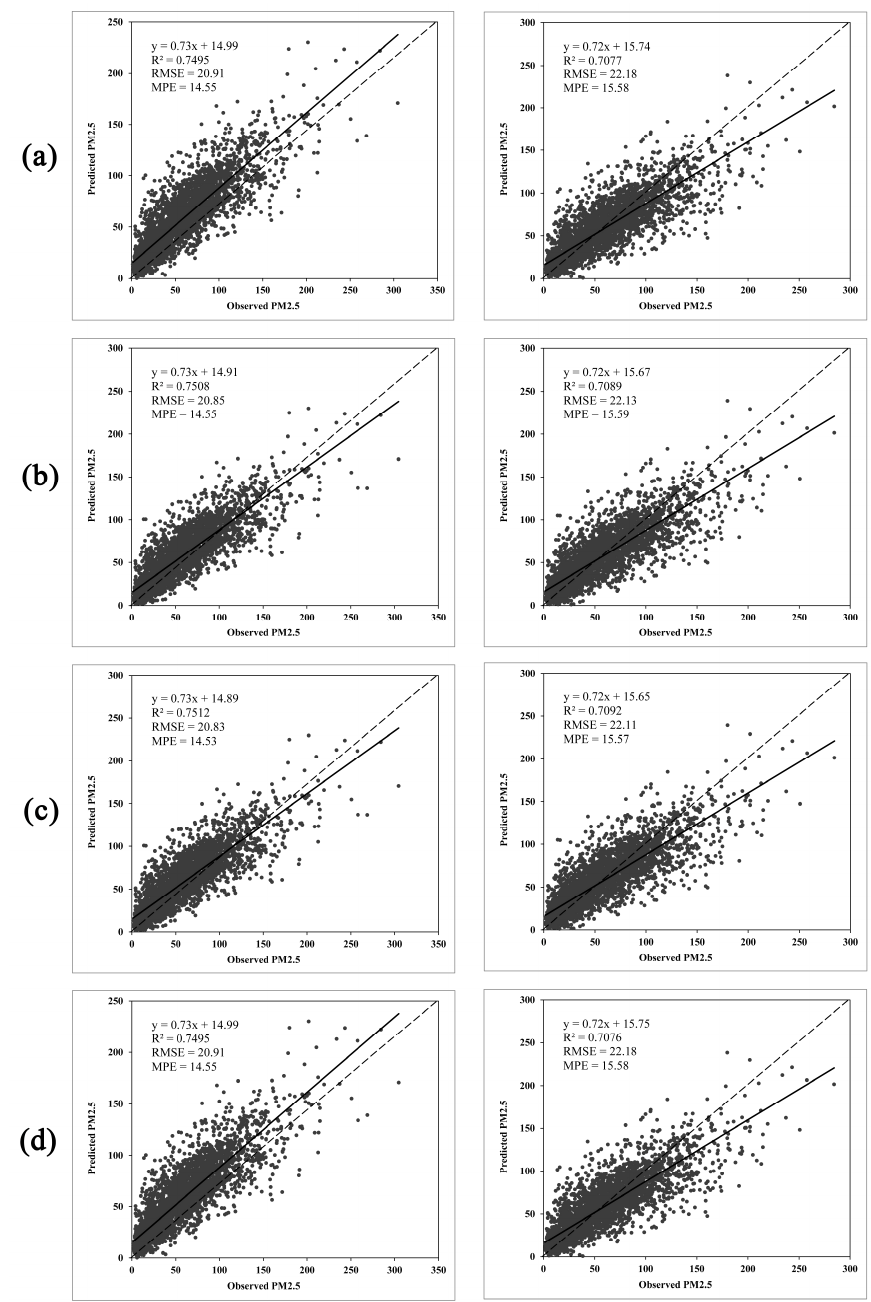
Figure 3. Results of model fitting ( left column ) and cross validation ( right column ). The dashed lines are the 1:1 lines as references: ( a ) Meteor_LME, ( b ) NDVI_LME, ( c ) NTL_LME, and ( d ) VANUI_LME.